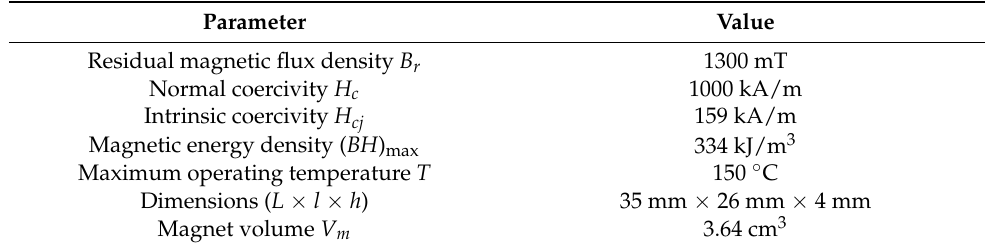
Table 2. N42SH magnets’ parameters.